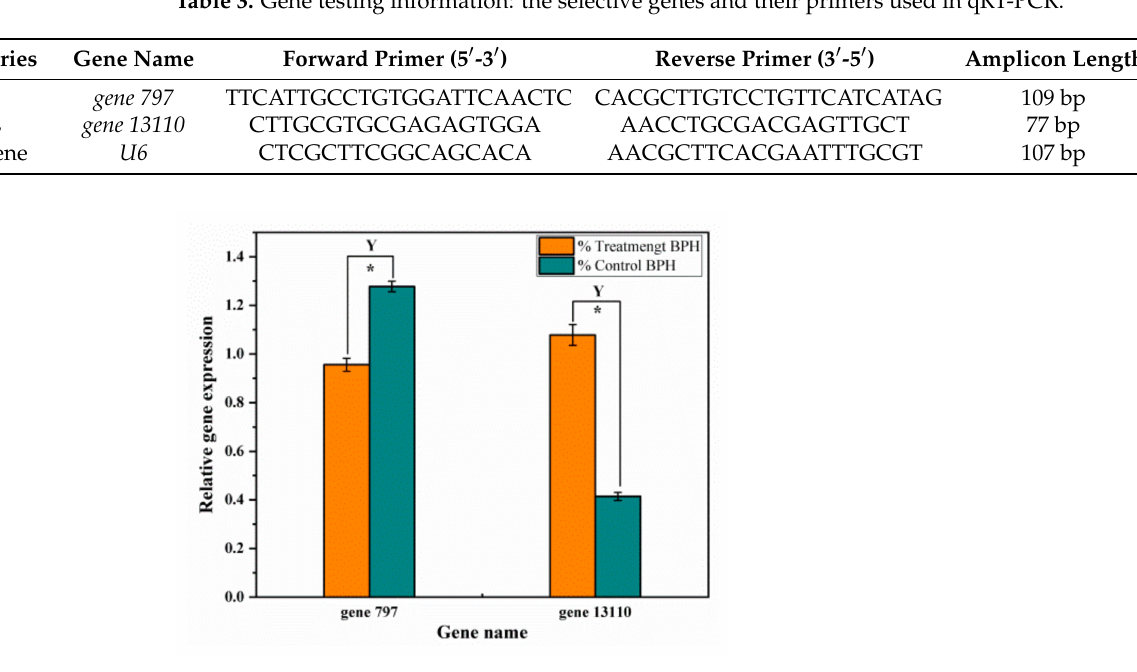
Figure 9. Relative expression levels of two genes ( gene 797 and gene 13110 ) in BPHs treatment and control groups validated through qRT-PCR analysis. *—indicated significant difference between treatment and control of relative gene expression ( p < 0.05), Y—indicated that the up/downregulated of qRT-PCR was consistent with the transcriptome